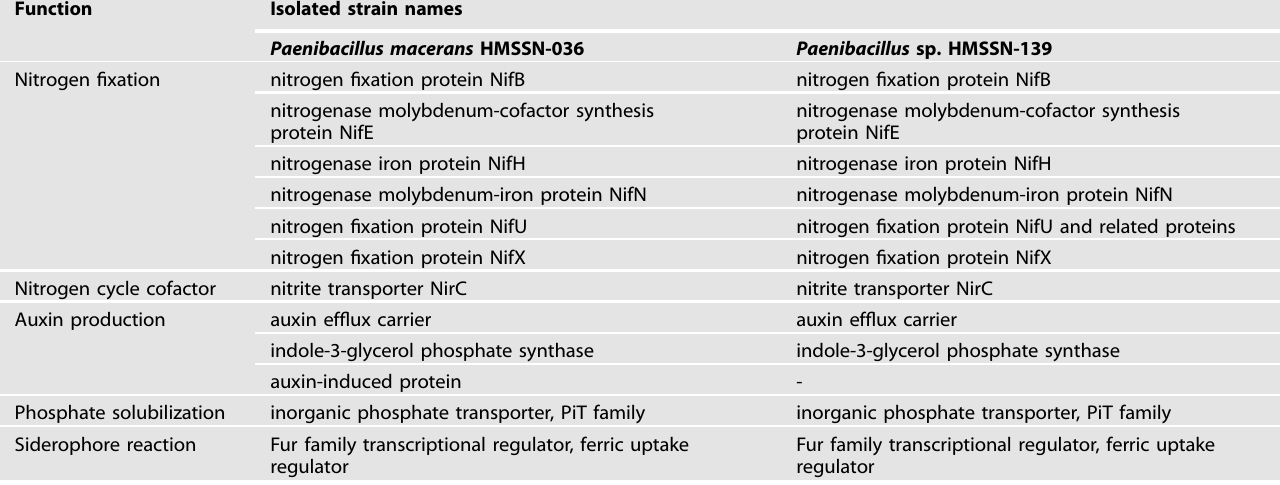
the same Paenibacillus increased in the soil. Furthermore, genome analyses showed the presence of genes for nitrogen fi xation, auxin production, phosphate solubilization, and siderophore reactions, such as PGPR (Table 1 and S7 – S10). Based on genomic information, biological assays were performed for auxin production, siderophore reaction, and phosphate solubilization and all of these assays were